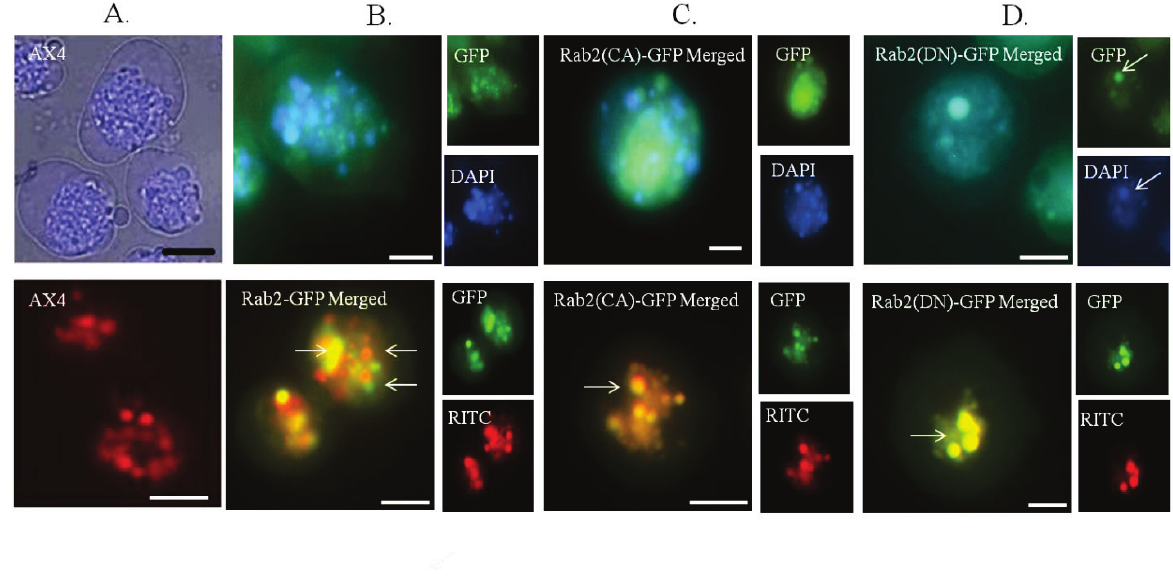
Figure 3. DdRab2(DN) associates with lysosomes and endosomes. ( A – D top panel) Distribution of LysoTracker ® dye in the AX4 cell line ( A ) and overlaid images of LysoTracker ® blue (DAPI) with GFP visualization in the Rab2-GFP ( B ) over-expressing, Rab2(CA)-GFP ( C ), Rab2(DN)-GFP ( D ) cell lines. The Rab2-GFP over-expressing ( B ), and Rab2(CA)-GFP ( C ) cell lines do not show association with the lysosomes. Rab2(DN)-GFP cells show co-localization with the lysosomes. ( A – D bottom panel) The vesicles of the endocytic system from endosome to lysosome are shown as red staining membranes due to the uptake of RITC-dextran after 60 min of treatment. ( A ) WT-AX4 cells with the endosomes shown in red. ( B ) Rab2-GFP over-expressing, and Rab2(CA)-GFP ( C ), cells show partial association with the endosomal system (indicated by arrows). The Rab2(DN)-GFP ( D ) cells show complete association with the endosomal system.